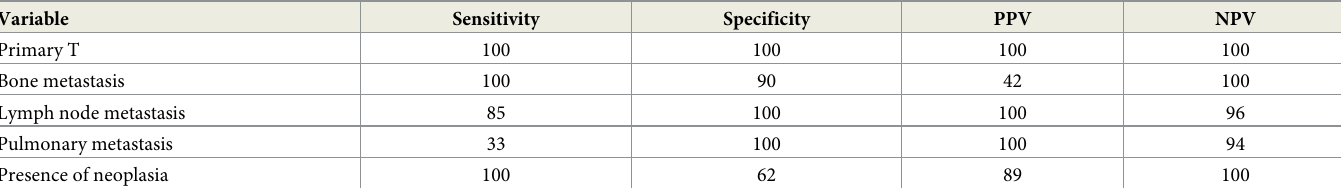
Table 5. WBMRI performance in relation to the reference standard.